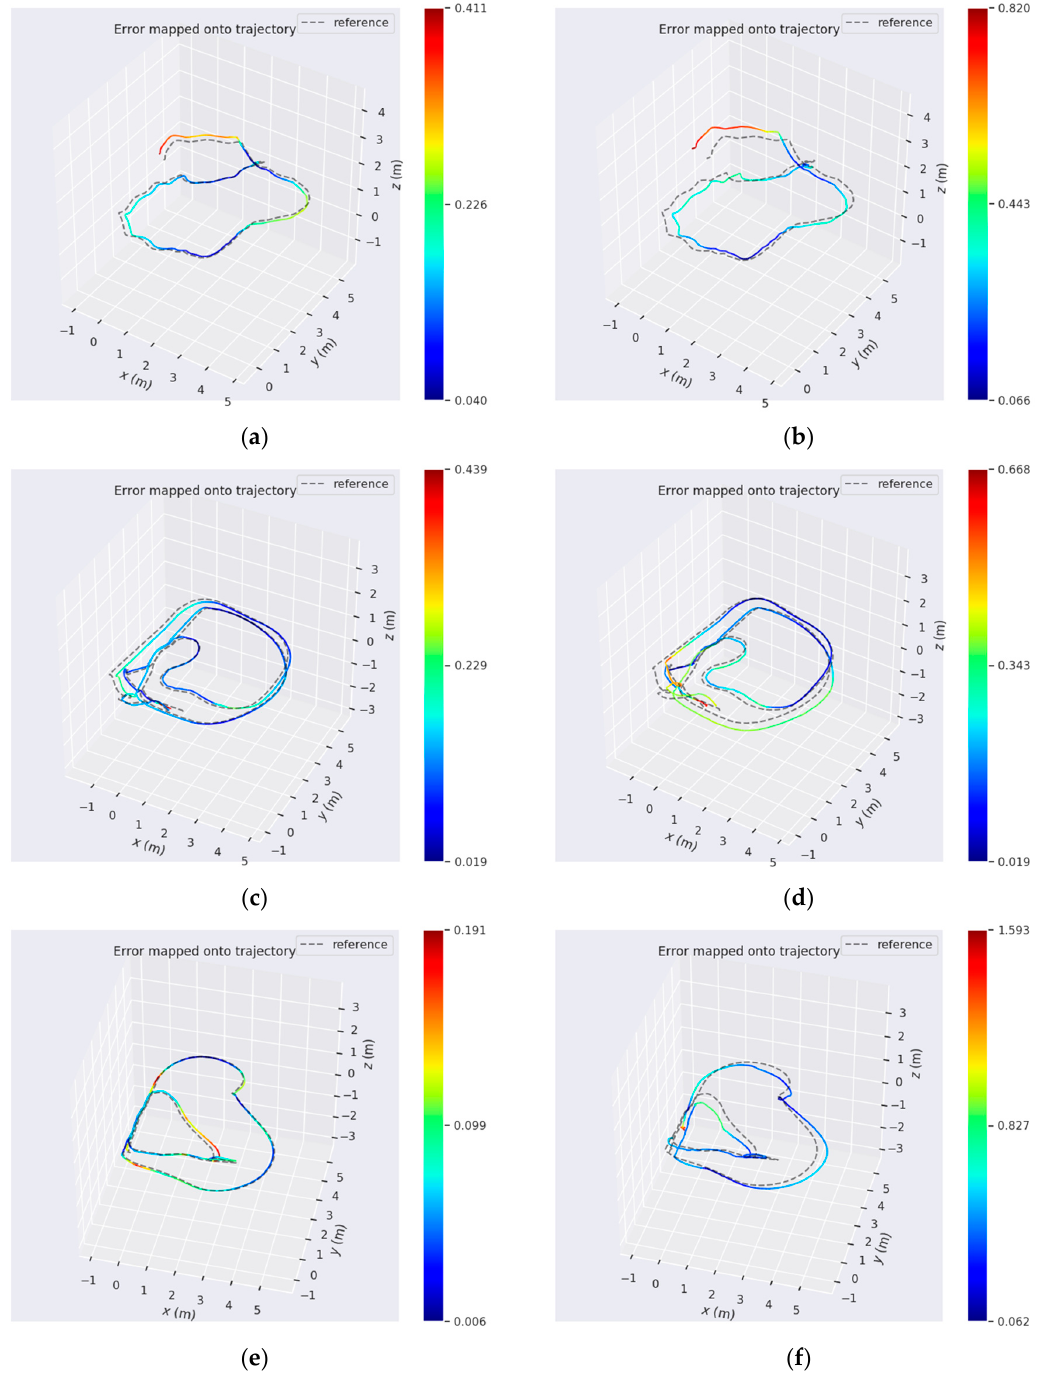
Figure 9. The comparative absolute translation errors in the several datasets. The three colorful trajectories of the left column are run with our system on: ( a ) the Handheld With More Rotation; ( c ) the Wheeled Fast; ( e ) the Wheeled Normal. The trajectories ( b , f ) are the results of VINS-MONO on the corresponding data. ( d ) shows the results of PLVIO on the corresponding data.